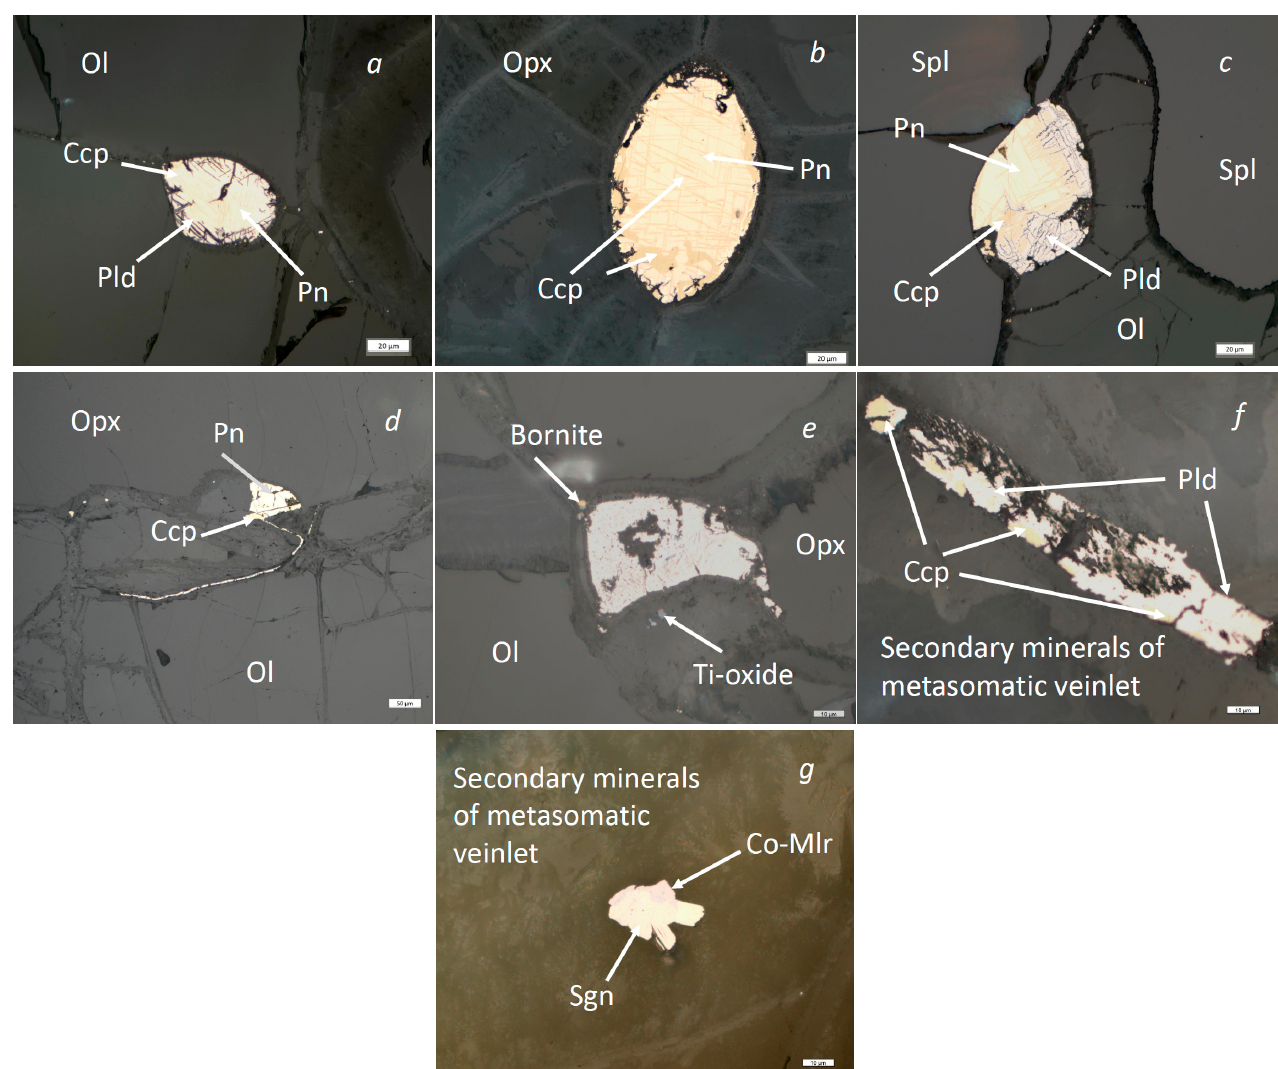
Figure 3. Reflected light photomicrographs of sulfide structural types from Cpx-poor Spl lherzolites: ( a ) multi-phase oval sulfide inclusion (e-type sulfide) in Ol. The main body consists of Pn with Ccp forming lamellae along the cleavage cracks; insignificant volume at the marginal part of the inclusion is occupied by Ccp. Cleaved polydymite (Pld) has developed along the edges of the inclusion; the scale bar is 20 μ m; ( b ) bi-mineralic Pn + Ccp sulfide inclusion (e-type sulfide) in Opx. The main body consists of Pn with Ccp forming lamellae along the cleavage cracks. Massive Ccp is developed at marginal parts of the inclusion. The scale bar is 20 μ m; ( c ) i-type interstitial multi-phase oval sulfide. The main body consists of Pn with Ccp forming lamellae along the cleavage cracks. mss is sporadically developed at the very edge of the sulfide bleb. Cleaved/cracked Pld is developed along the edges of the sulfide bleb, The scale bar is 20 μ m; ( d ) irregular interstitial (i-type) bi-mineral Pn + Ccp sulfide complicated by the bi-mineralic (Pn + Ccp) sulfide film along the silicate grain boundaries. The scale bar is 50 μ m; ( e ) interstitial spongy Cu-Ni mss. Bornite and Ti-oxide crystals are developed around the mss. Tiny Fe-oxide crystals are developed within the main body of the mss. The scale bar is 10 μ m; ( f ) elongated bi-mineral Pn + Ccp sulfide of m-type in a metasomatic veinlet. The scale bar e is 10 μ m; ( g ) skeletal siegenite (Sgn) + Co-milerite (Mlr) crystal (m-type sulfide) in a metasomatic veinlet. The scale bar is 10 μ m.